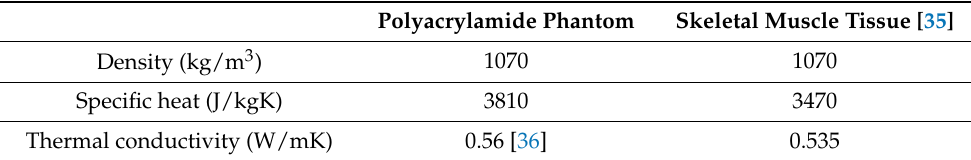
Table 2. Thermal properties for tissue-equivalent phantom and human muscle.